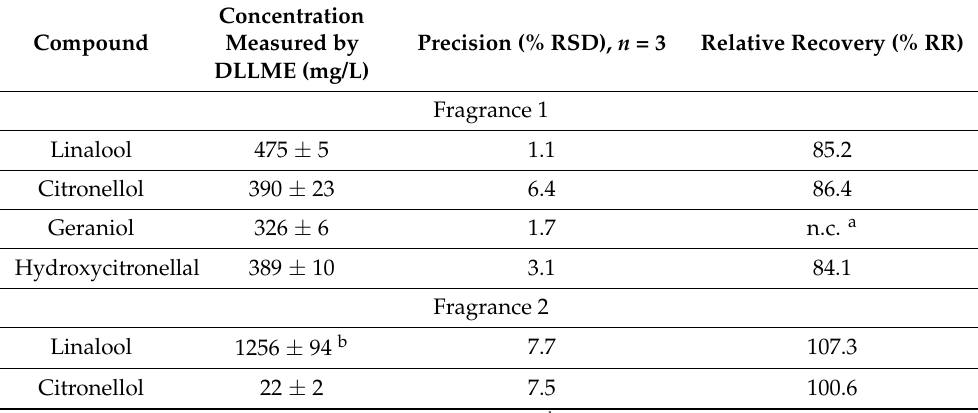
Table 3. Quantification results for the target analytes in two commercial fragrances measured by DLLME and expressed as mg/L ( ± SD), with precision data and % relative recovery (%RR) calculated on the basis of the concentrations obtained by direct injection. Concentration Compound Measured by DLLME